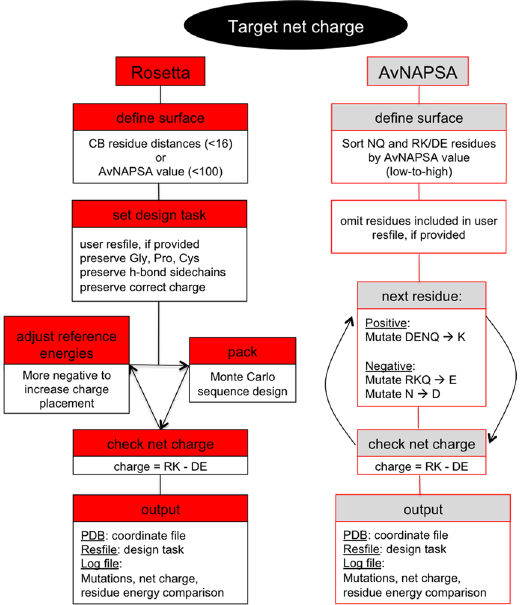
Figure 2 . Workflow of two protocols for supercharging protein surfaces . Both protocols begin by defining the surface of the protein of interest, and if provided, reading a residue file that specifies residues to not mutate. AvNAPSA forcibly mutates NQ and DE/RK in order of solvent accessibility. Rosetta uses Monte Carlo side chain placement guided by computed energies to mutate any surface residue except G, P, C, and hydrogen-bonded side chains, and charged-residue reference energies are adjusted to vary net charge. Both protocols are set up to achieve a desired net charge (above), or to specified reference energies (Rosetta) or surface cutoff (AvNAPSA). Output includes the PDB coordinate file of the redesigned protein, the residue file specifying the allowed mutations, and a log file with information such as residues mutated, number of mutations, net charge, residue energies, and a PyMOL selection command to conveniently view the